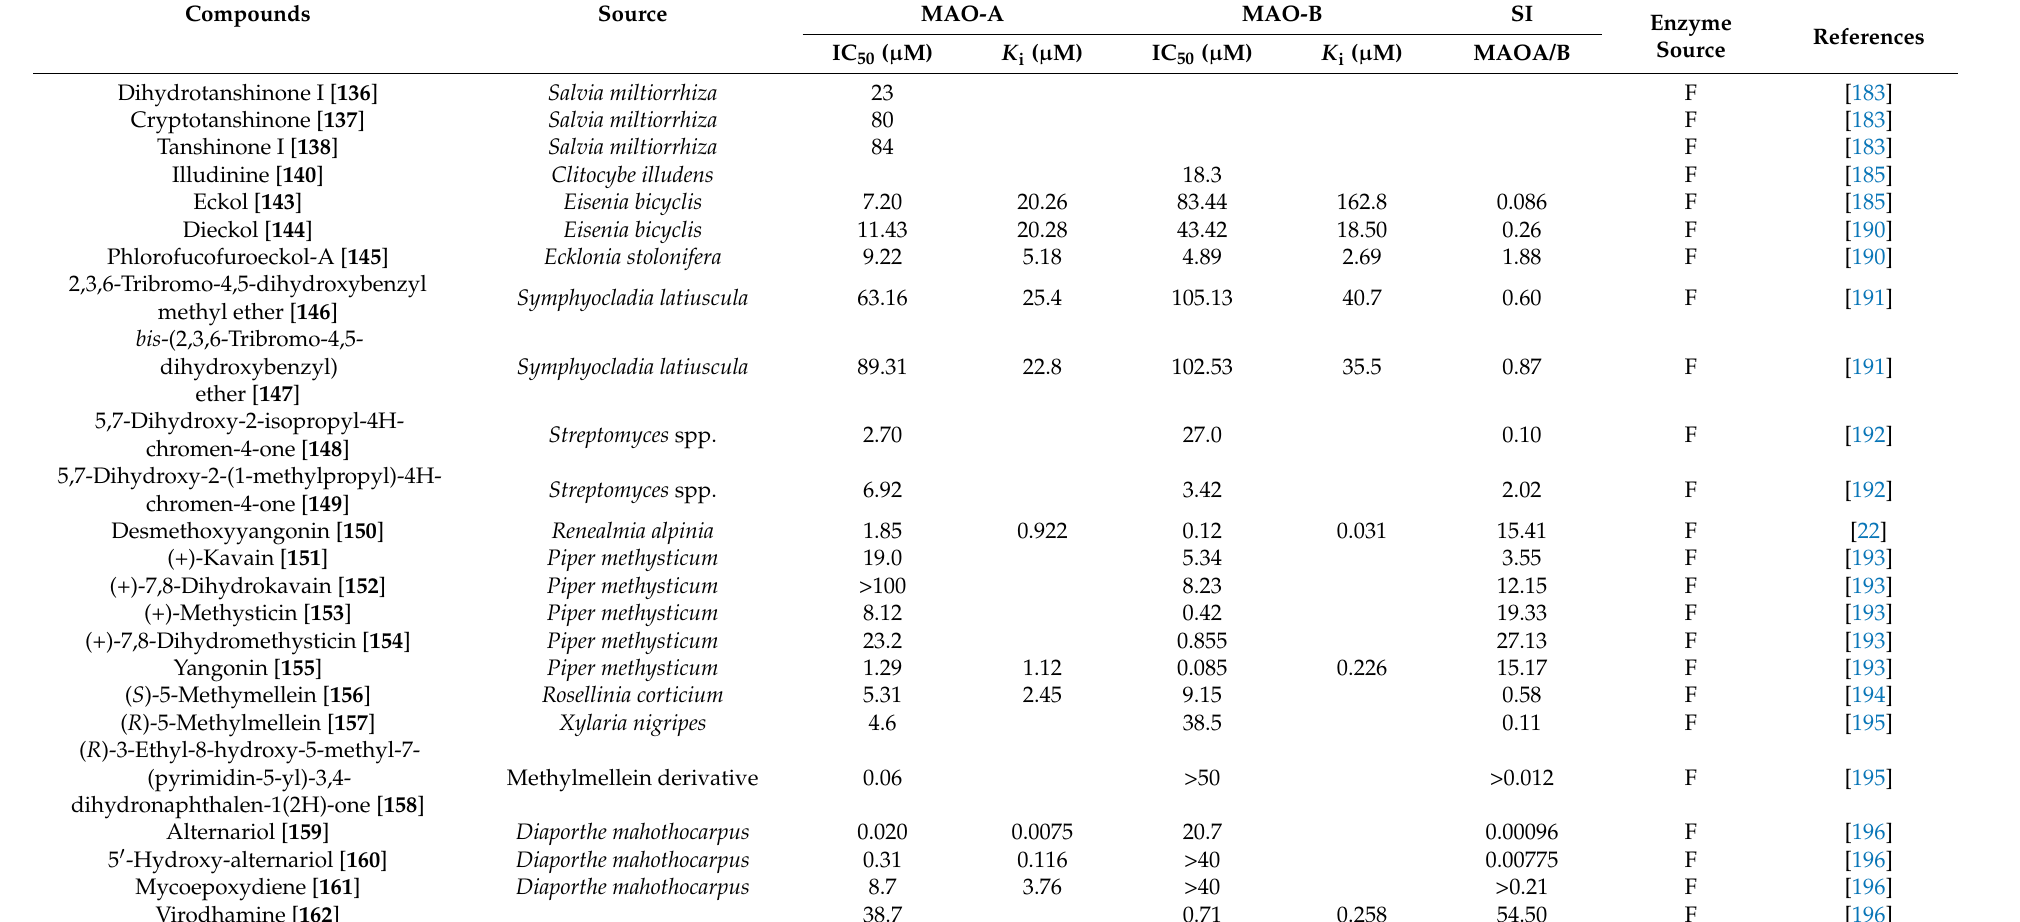
Table 7. Terpenoids, marine sources, and miscellaneous natural product inhibitors of MAO-A and MAO-B. Compounds Source MAO-A MAO-B SI Enzyme